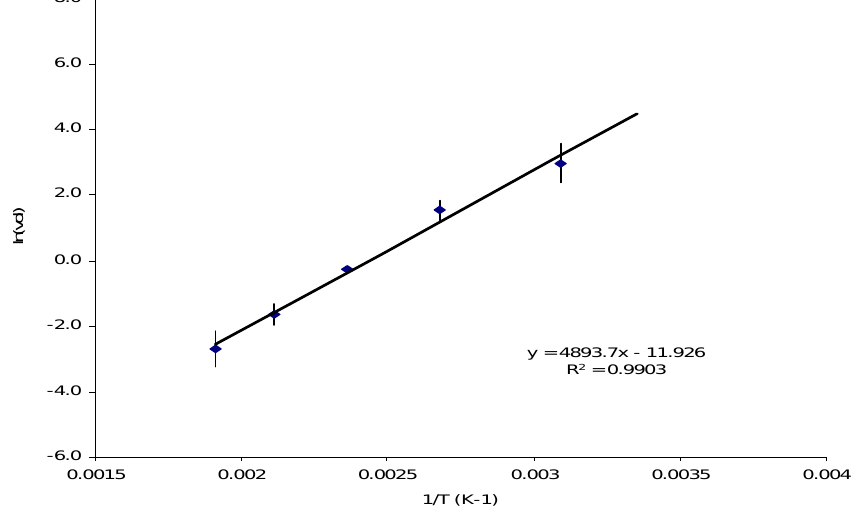
Fig. 1. Measured 1 H eff vap of organic aerosol generated from the isoprene + OH reaction conducted in the absence of NO x in Experiment 3.